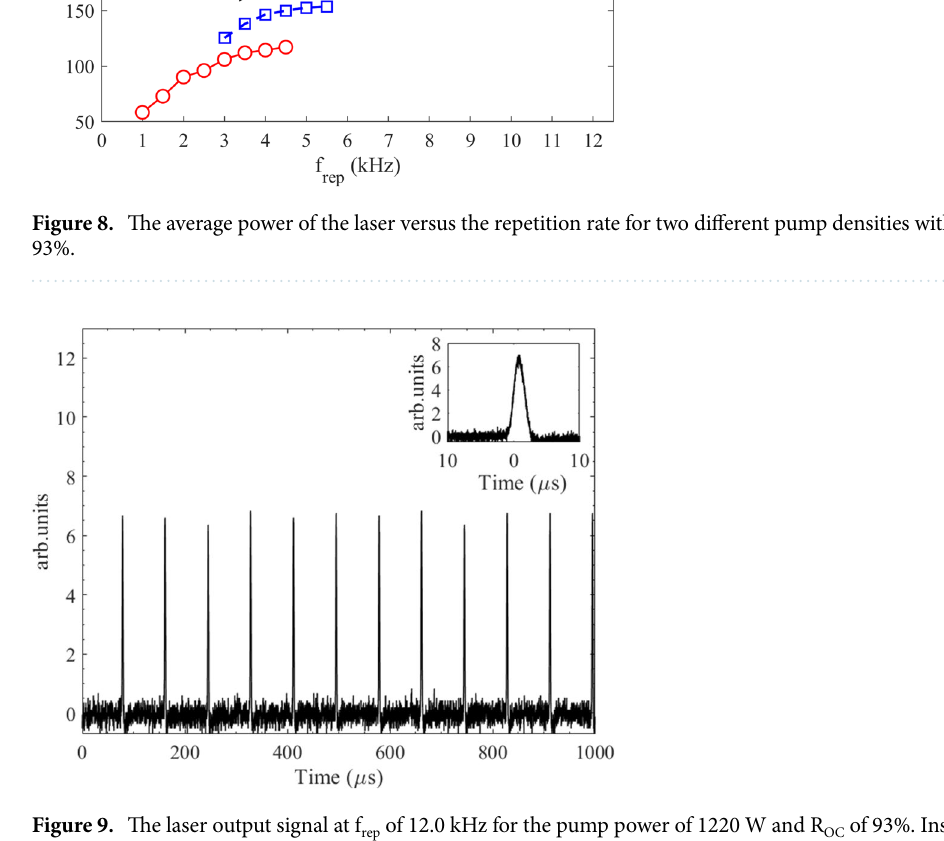
Figure 9. The laser output signal at f rep of 12.0 kHz for the pump power of 1220 W and R OC of 93%. Inset: single pulse time profile indicating the pulse duration is about 1.25